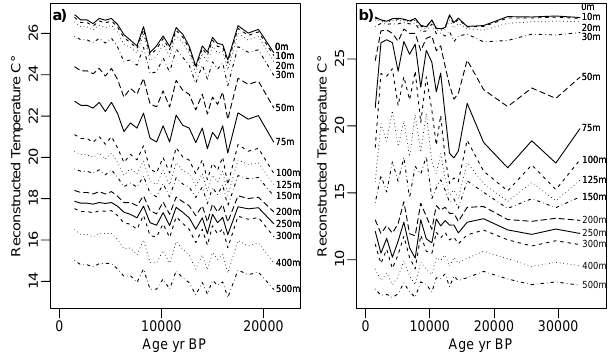
Fig. 4. Warm-season reconstructions for different water depths from (a) V22-222 and (b) V30-36.